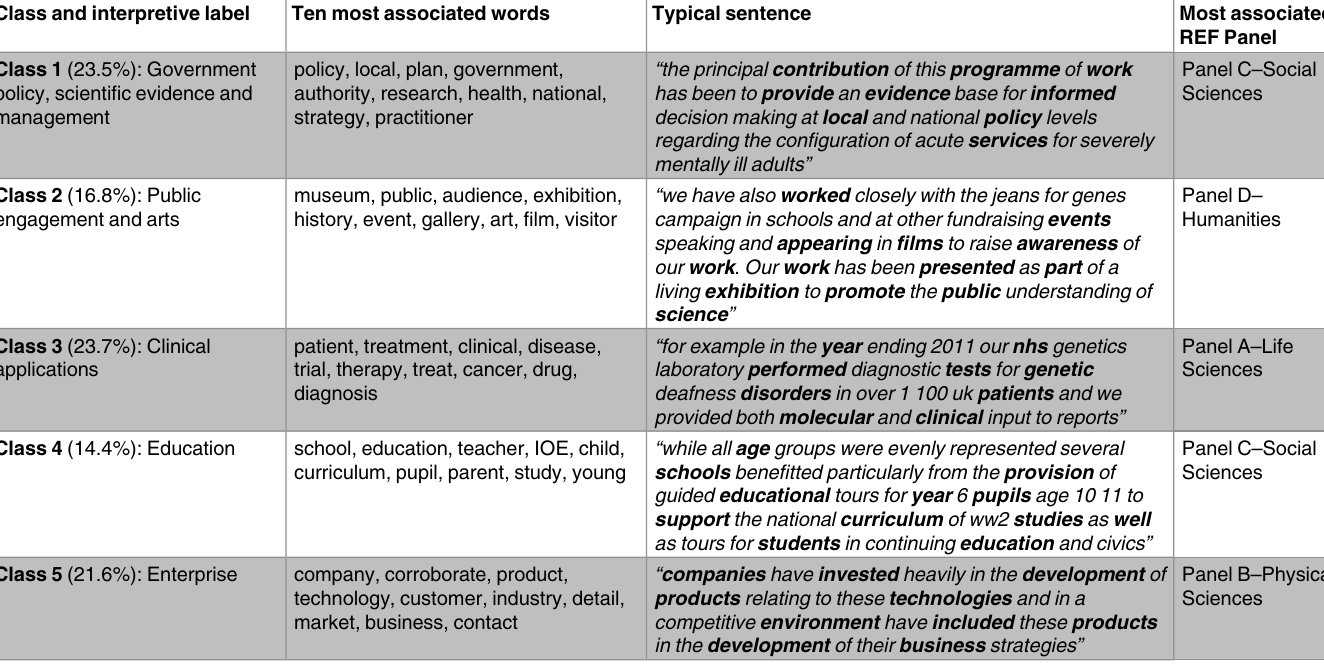
Table 3. Classesproduced in the analysis of UCL impact case studies (all panels